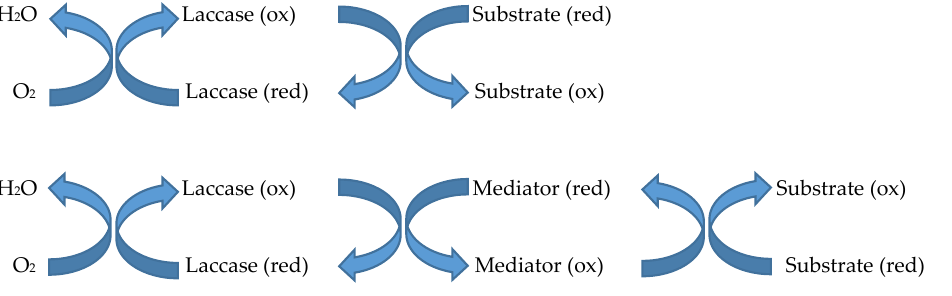
Figure 4. Mechanism of action of laccases (modified from [22]). ox—oxidized state; red—reduced state.